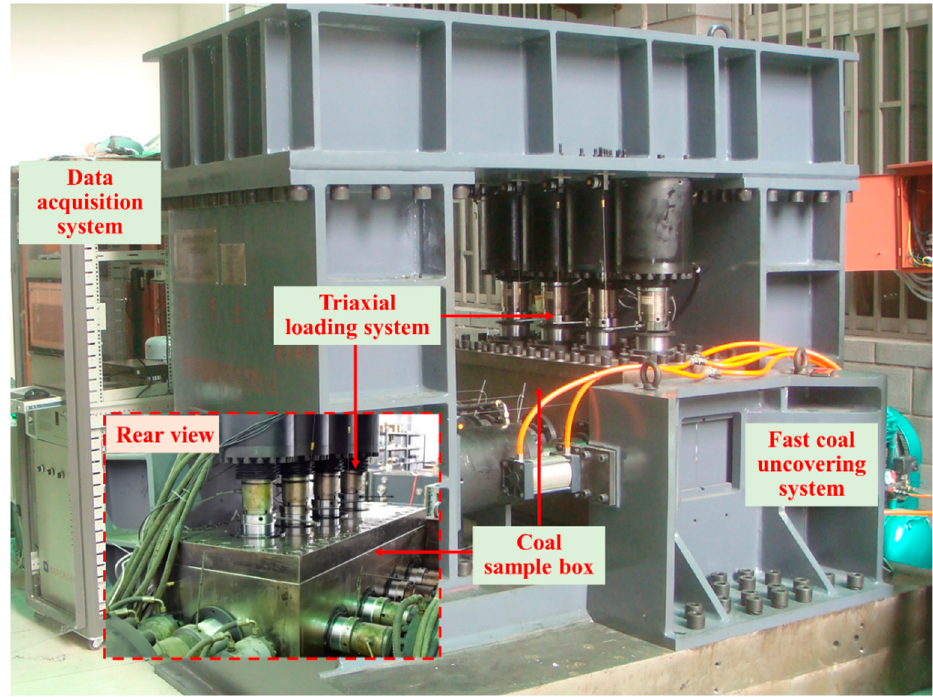
Figure 2. Photograph of the self ‐ developed large ‐ scale multifunctional equipment.